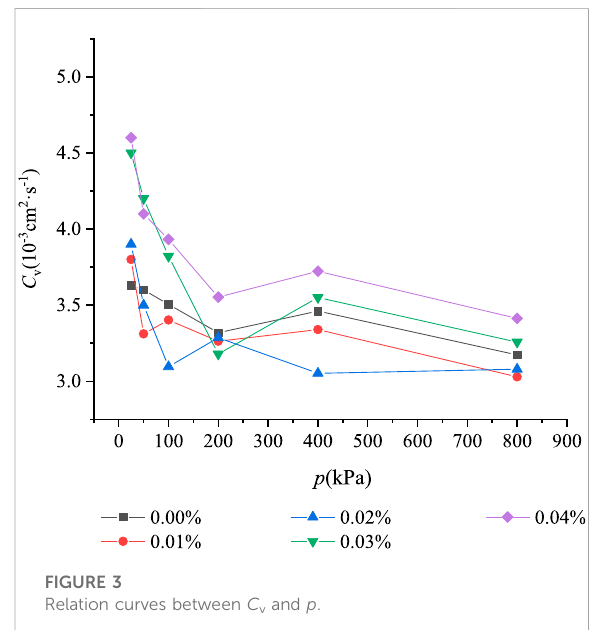
FIGURE 3 Relation curves between C v and p